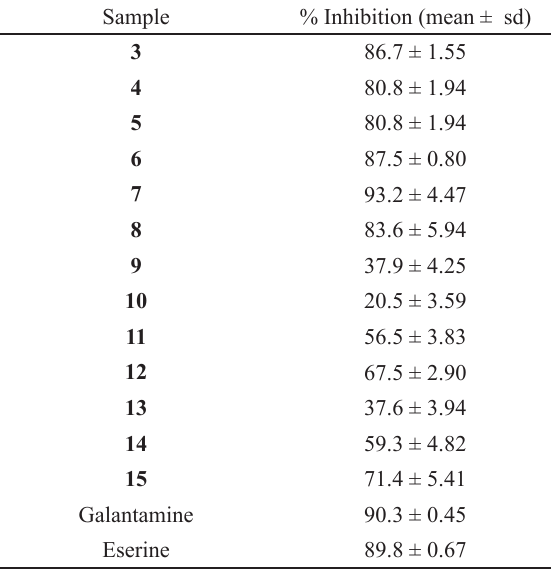
Inhibition (%) of acetylcholinesterase by hydroxyl amides